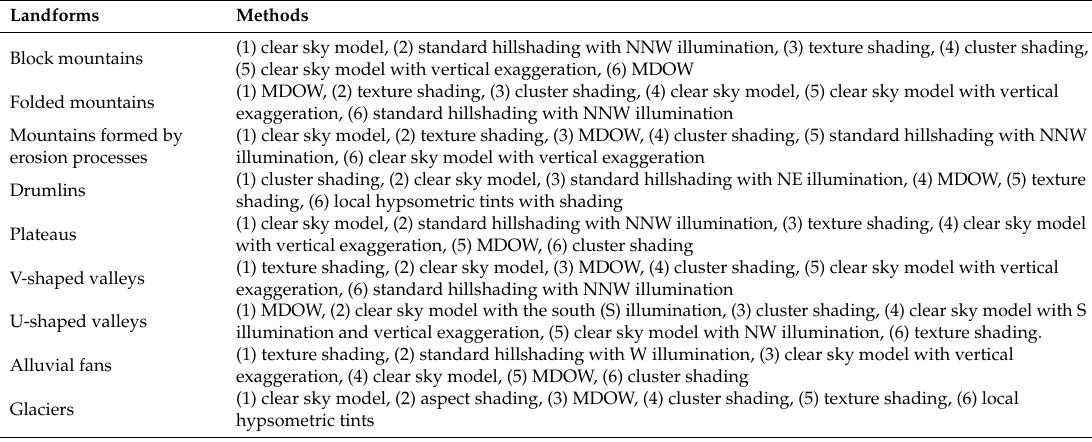
Table 1. Landforms and methods chosen for the